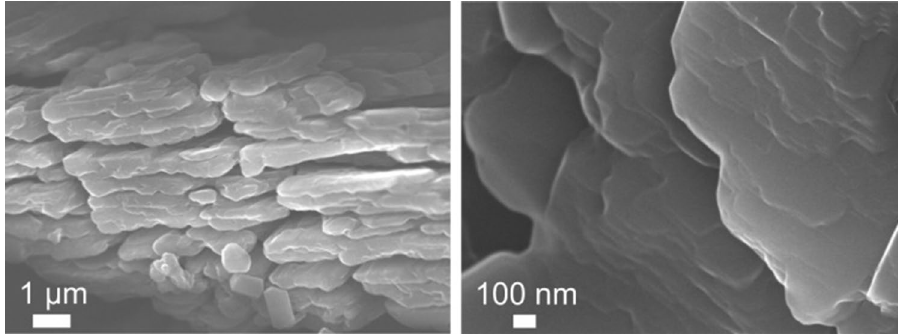
Figure 3. SEM images of Cat-CrNP